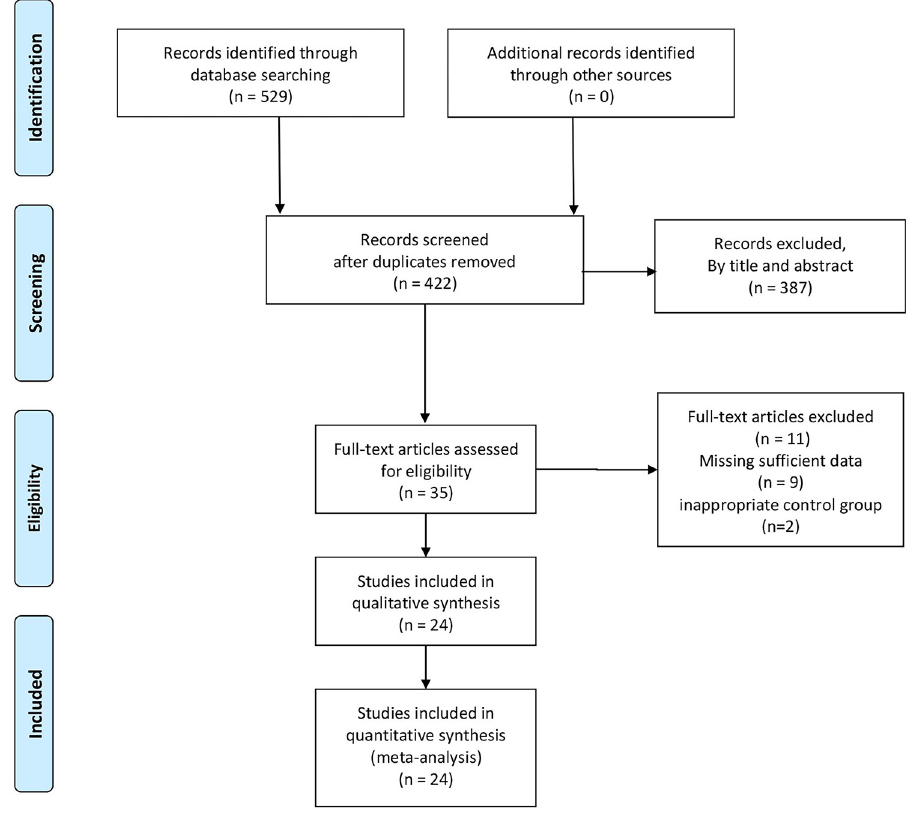
Fig 1. The PRISMA flow